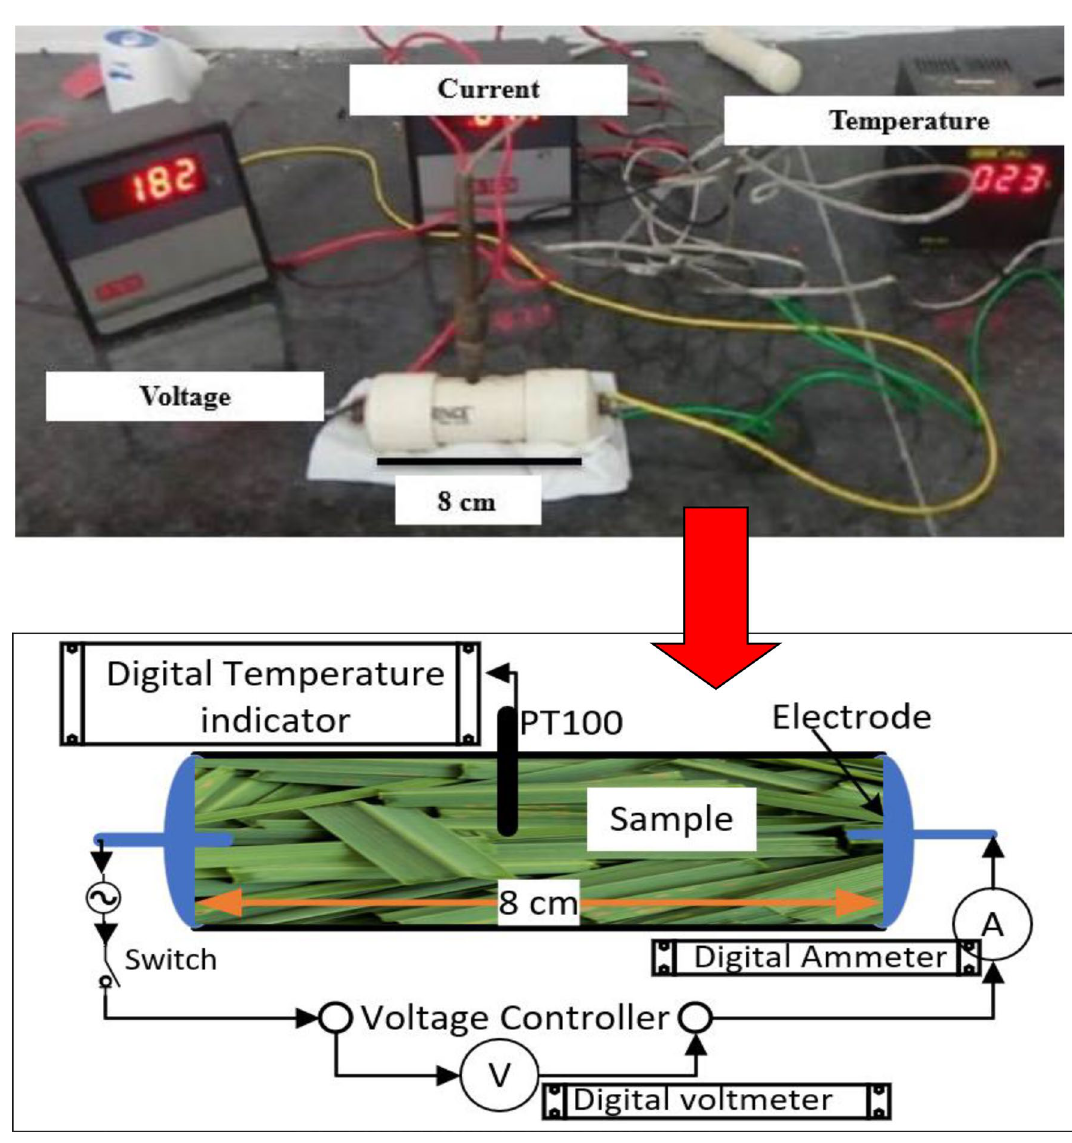
Figure 1. Experimental set-up for measurement of electrical